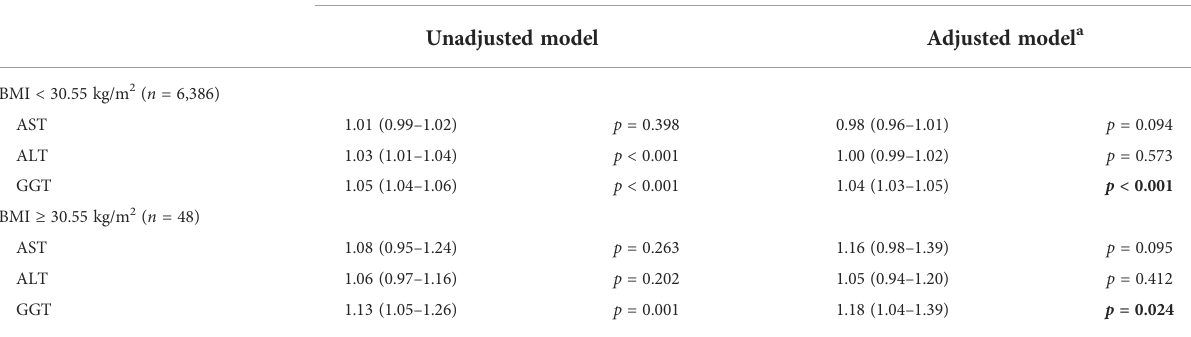
TABLE 2 The linear regression model of the relationship between liver enzymes and DM risk in BMI